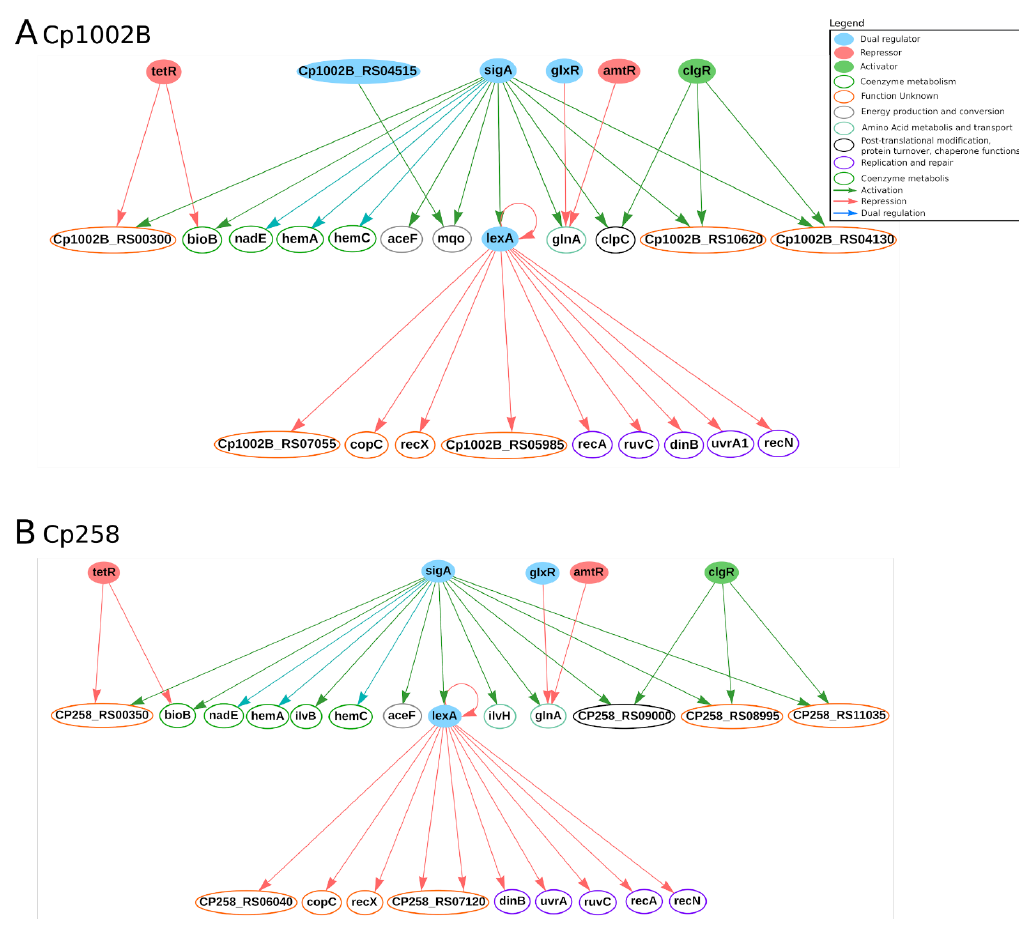
Figure 5. Regulatory interactions of SigA in C. pseudotuberculosis 1002B ( A ) and C. pseudotuberculosis 258 ( B ) from CoryneRegNet 7. In the network, nodes represent the genes and arrows represent the regulatory interactions. The functional classification was performed using the database Eggnog [90].